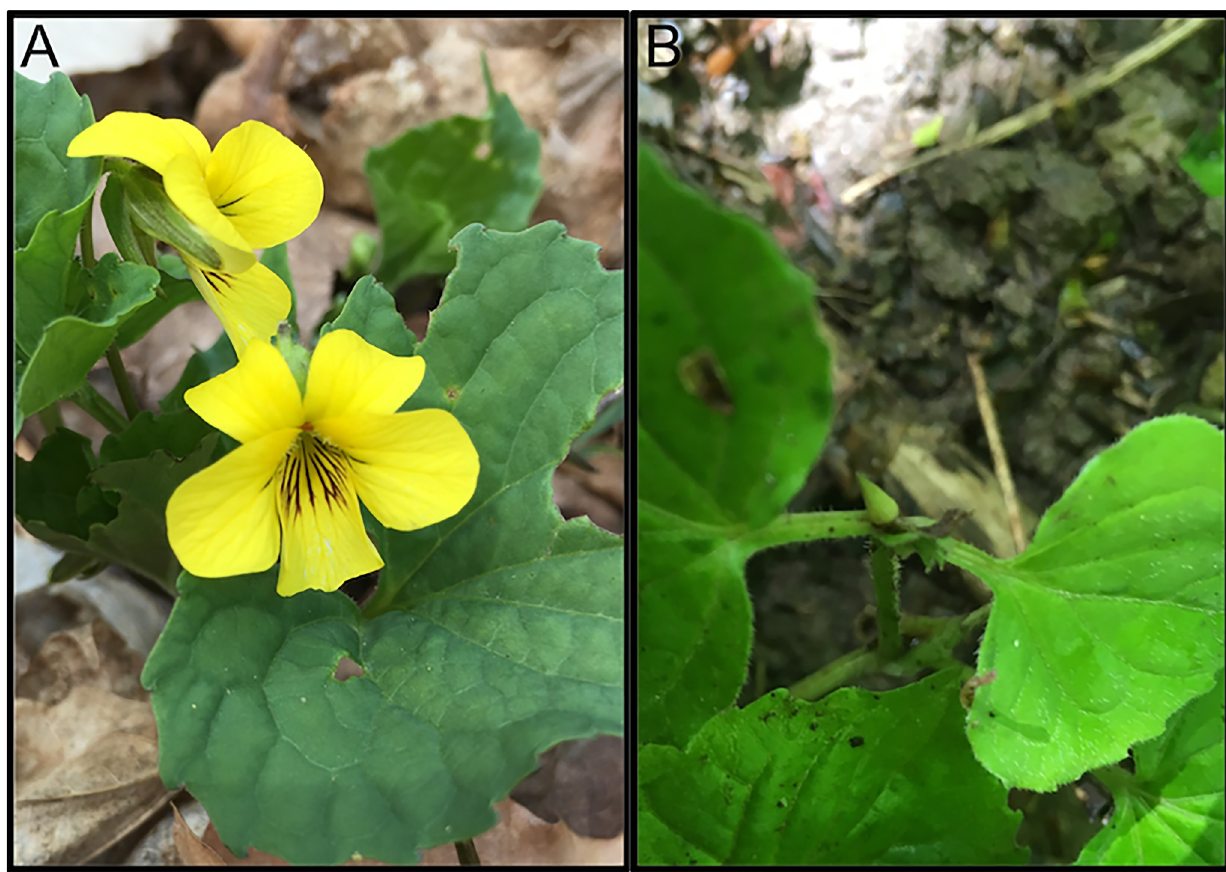
Fig 1. Viola pubescens var scabriuscula bearing A) chasmogamous and B) cleistogamous flowers. Photographs were taken over a native population in Sells Park, Athens County, Ohio.